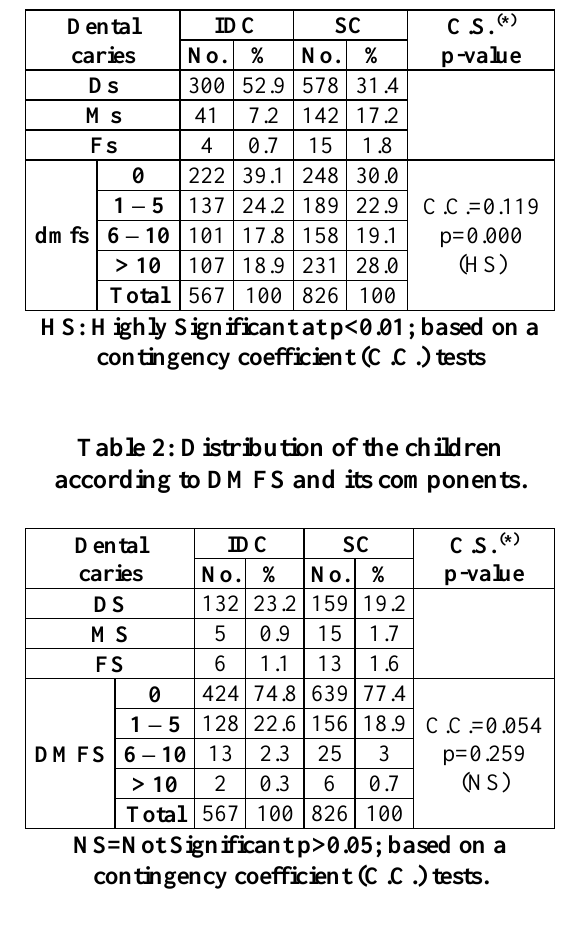
Table 1: Distribution of the children